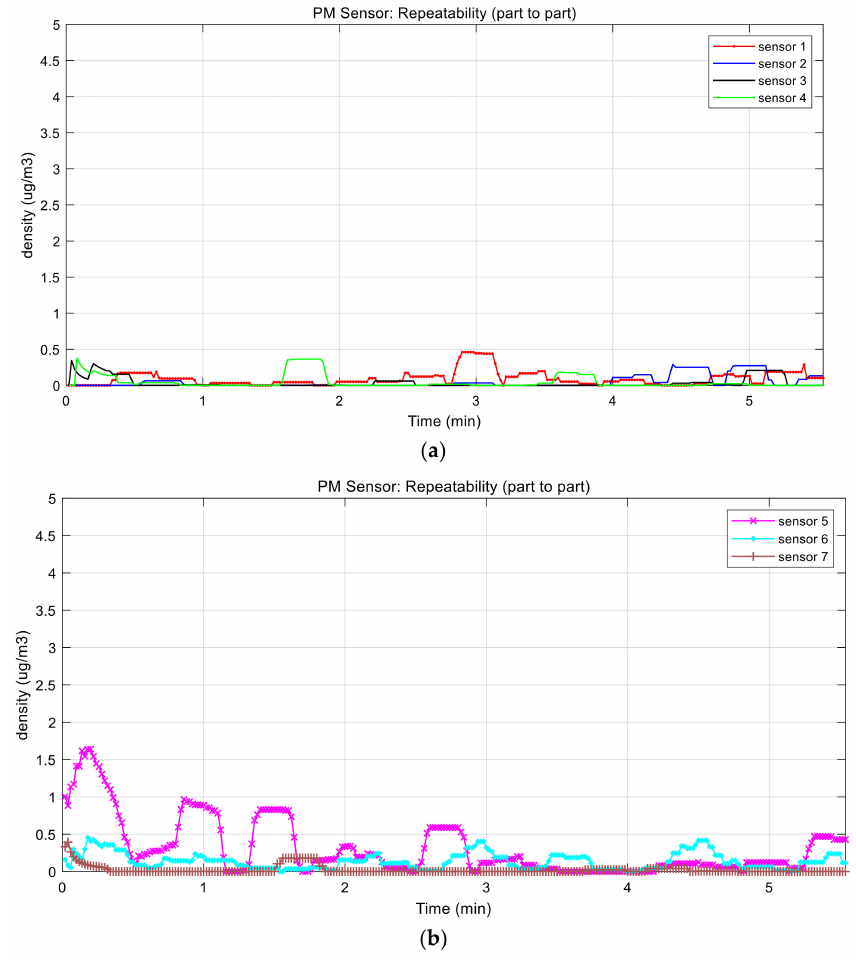
Figure 14. Performance evaluation: part-to-part repeatability: ( a ) data collected from sensor 1 to 4 and ( b ) data collected from sensor 5 to